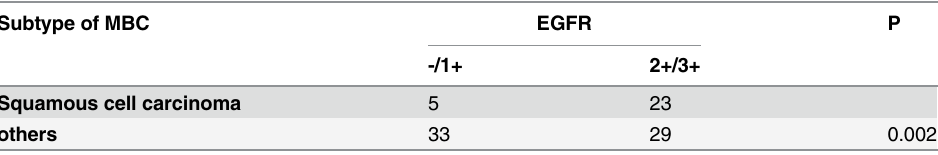
Table 5. EGFR overexpression of